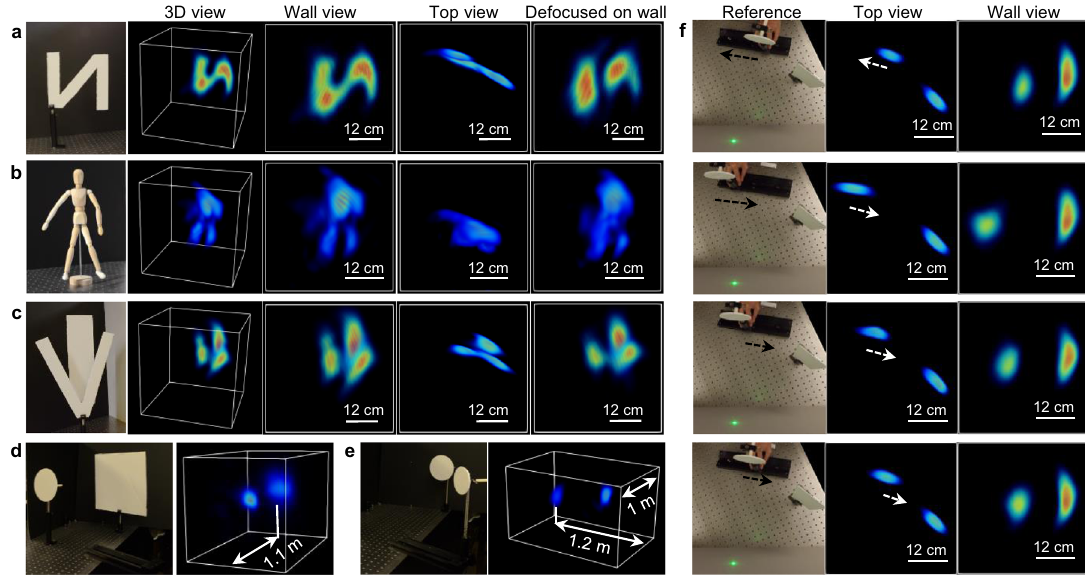
Fig. 4 NLOS imaging by LIFT. a – c Reconstructed images of three static hidden scenes: a letter N, a mannequin, and letters V and I at different depths, with letter I being partially occluded by V. The mannequin is reconstructed within a smaller volume than others for better visualization. The images from left to right are the reference photographs, 3D rendering of the reconstructed scenes, and images of the scene from the wall and top perspectives, respectively. The last column shows the reconstructed scene when the camera is defocused on the wall. d , e imaging over 1-meter scale (beyond the wall size) using 100 laser shots (total acquisition time of 1 s). The rendering dynamic range is compressed here to emphasize the object at a large distance. f Representative frames of NLOS imaging of a moving object at a 30 Hz video rate. The dashed arrows indicate the movement direction. The color map is ‘ jet ’ with a normalized